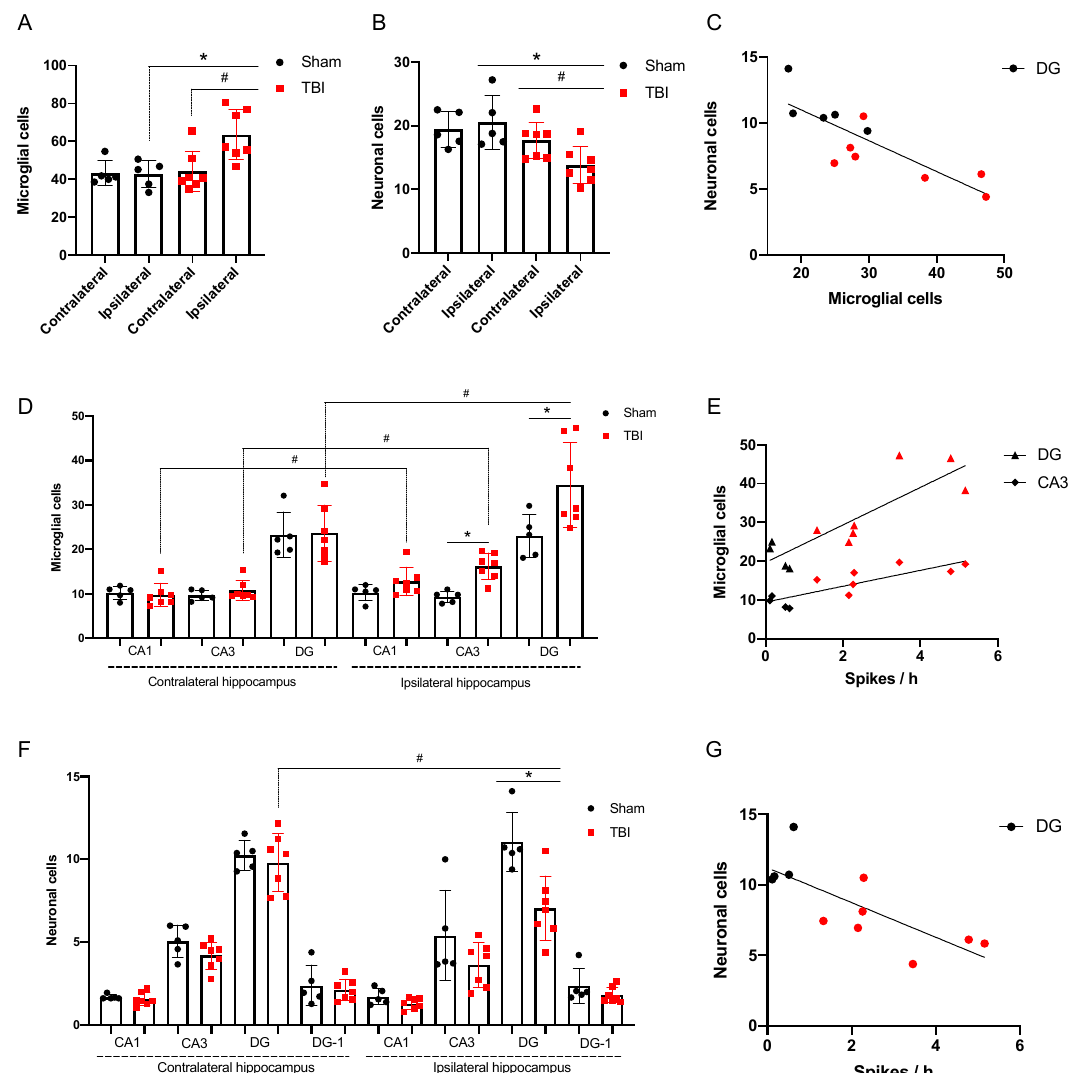
Figure 7. Distant damage to the hippocampus and spike occurrence. ( A ) Microglial cell density in the hippocampus (Iba-staining); ( B ) Neuronal cell density in the hippocampus (Nissl staining); ( C ) Neuronal cell loss correlates with microglial cell density in the ipsilateral dentate gyrus (DG) (red dots, rats with TBI and black dots, sham-operated animals, p = 0.001); ( D ) Microglial cell density in the hippocampal CA1 and CA3 fields and the DG. ( E ) Correlation between microglial cell density and spike occurrence on day 7 after TBI ( p = 0.001); ( F ) Neuronal cell density in the hippocampal CA1 and CA3 fields, and the DG; ( G ) Correlation between neuronal cell density and spike occurrence on day 7 after TBI ( p = 0.009). n = 7 (TBI) and n = 5 (Sham). * p < 0.05, Sham vs. TBI, Mann–Whitney test; # p < 0.05, ipsilateral vs. contralateral hemisphere, Wilcoxon test.